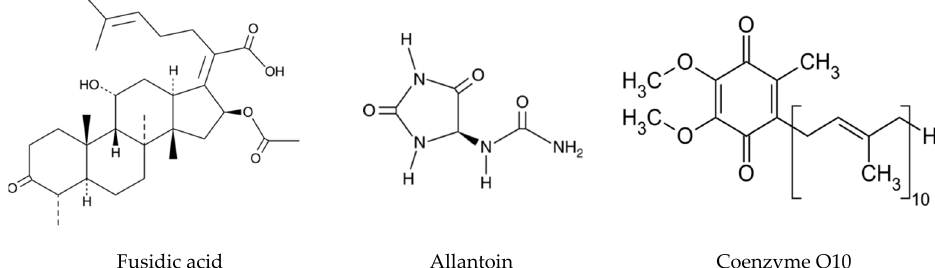
Figure 1. Chemical structure of APIs.